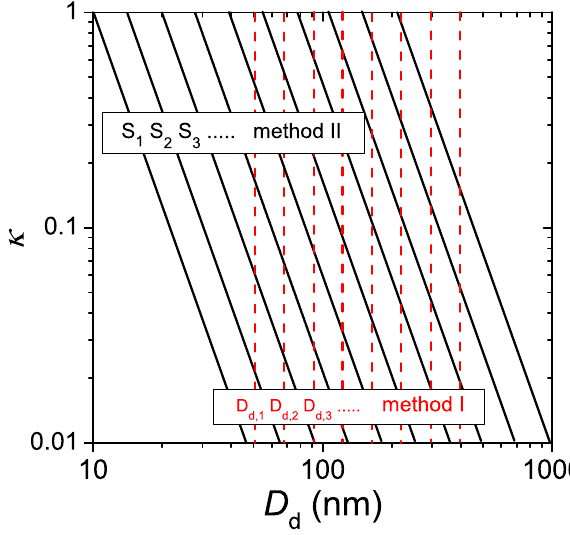
Fig. 2. Alternative methods of probing particle hygroscopicity distributions, H(κ,D d ) , by size-resolved CCN measurements: (1) method I or “ S scan” is represented by vertical dashed lines, in which the dry particle diameter D d is first kept constant and the water vapor supersaturation S is varied, then choosing another D d and repeating the same procedure; (2) method II or “ D d scan” is represented by the tilted solid lines, in which S is first kept constant and D d is varied, then choosing another S and repeating the same procedure.